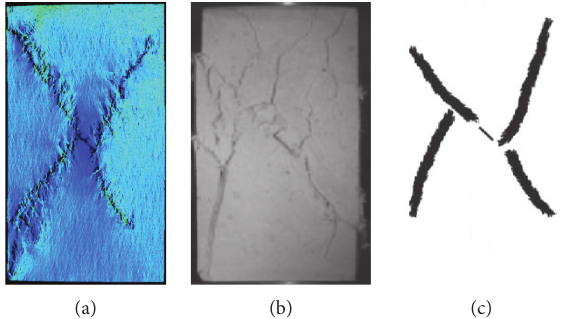
Figure 1: Comparison of numerical and experimental rock failure modes for